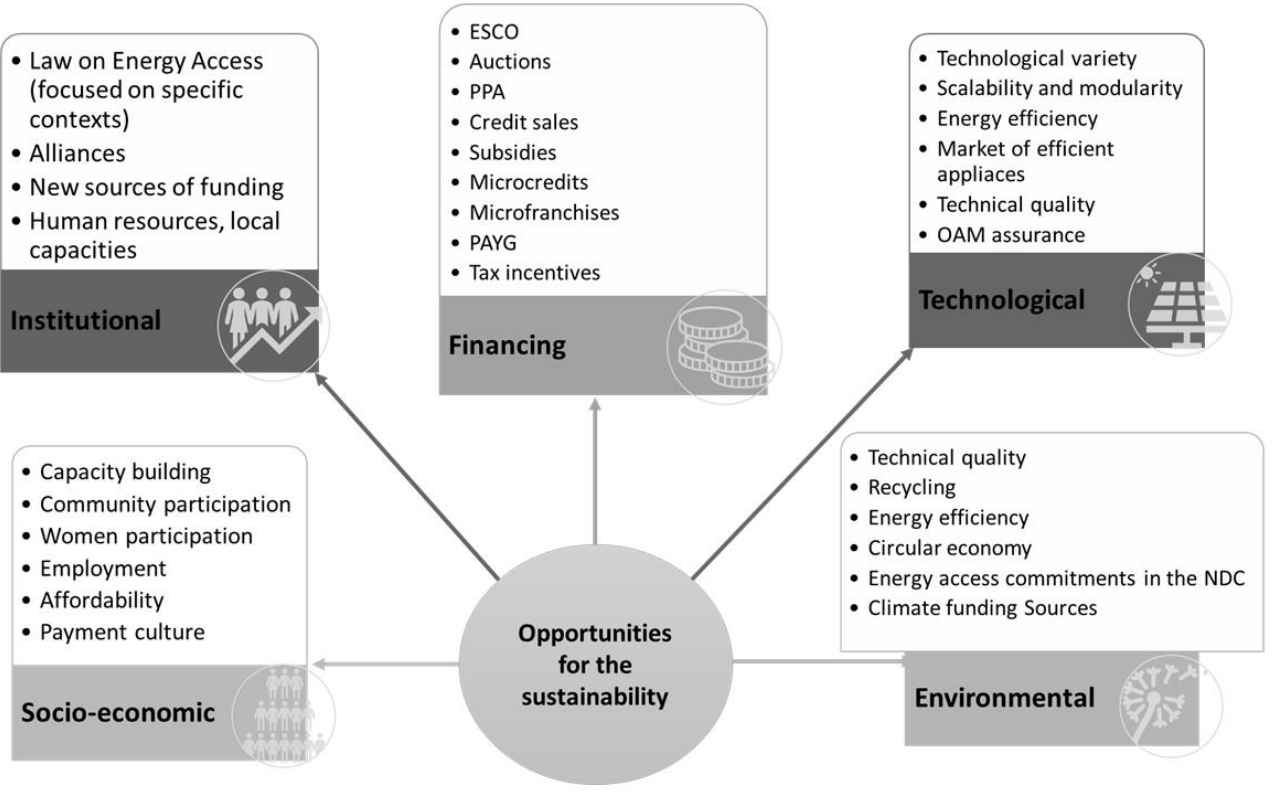
Figure 4. Opportunities for improving electrification projects with PV technology in the NIZ of Colombia. Own elaboration.